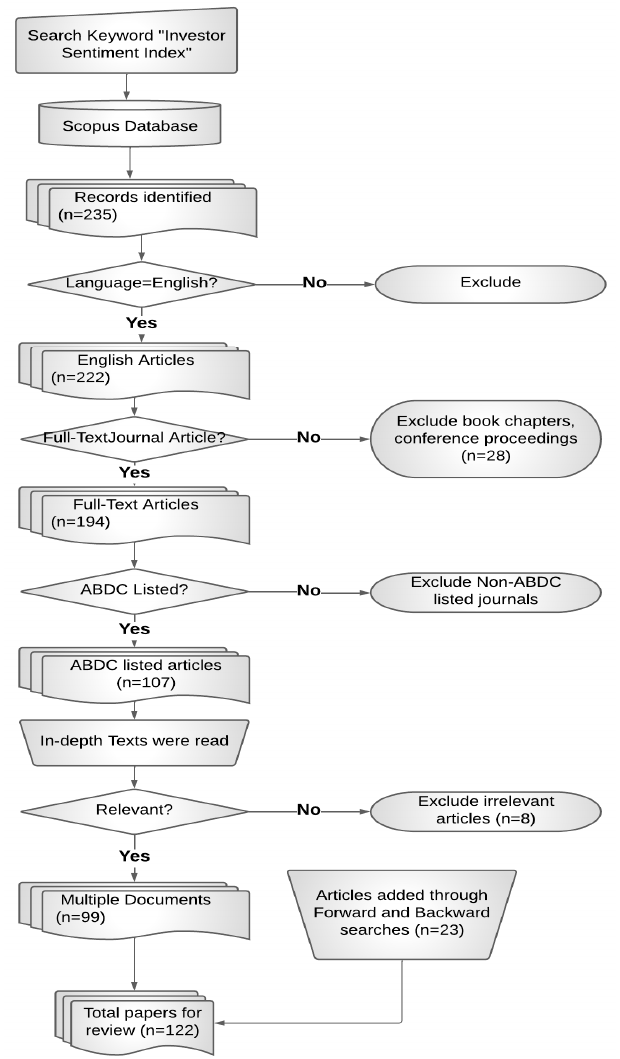
Figure 1. Flowchart depicting the process of selection of articles.